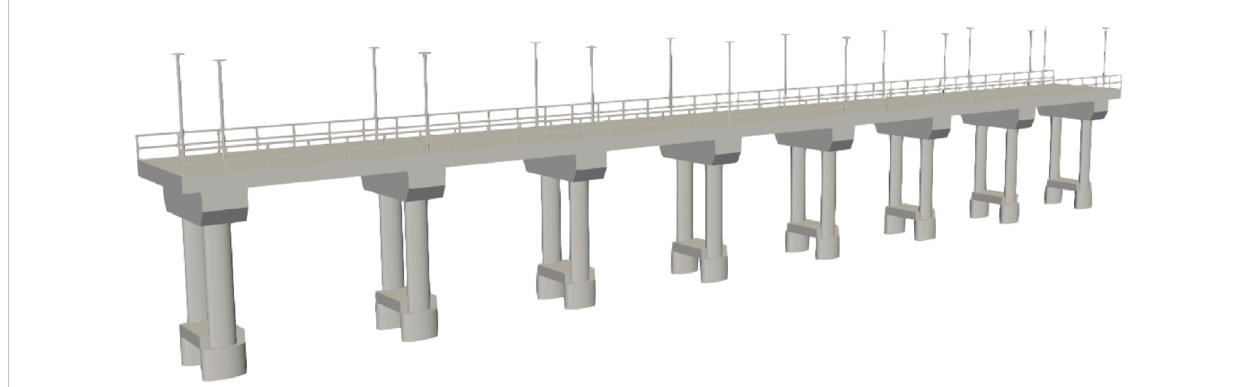
FIGURE 14 The bridge model used in this paper.